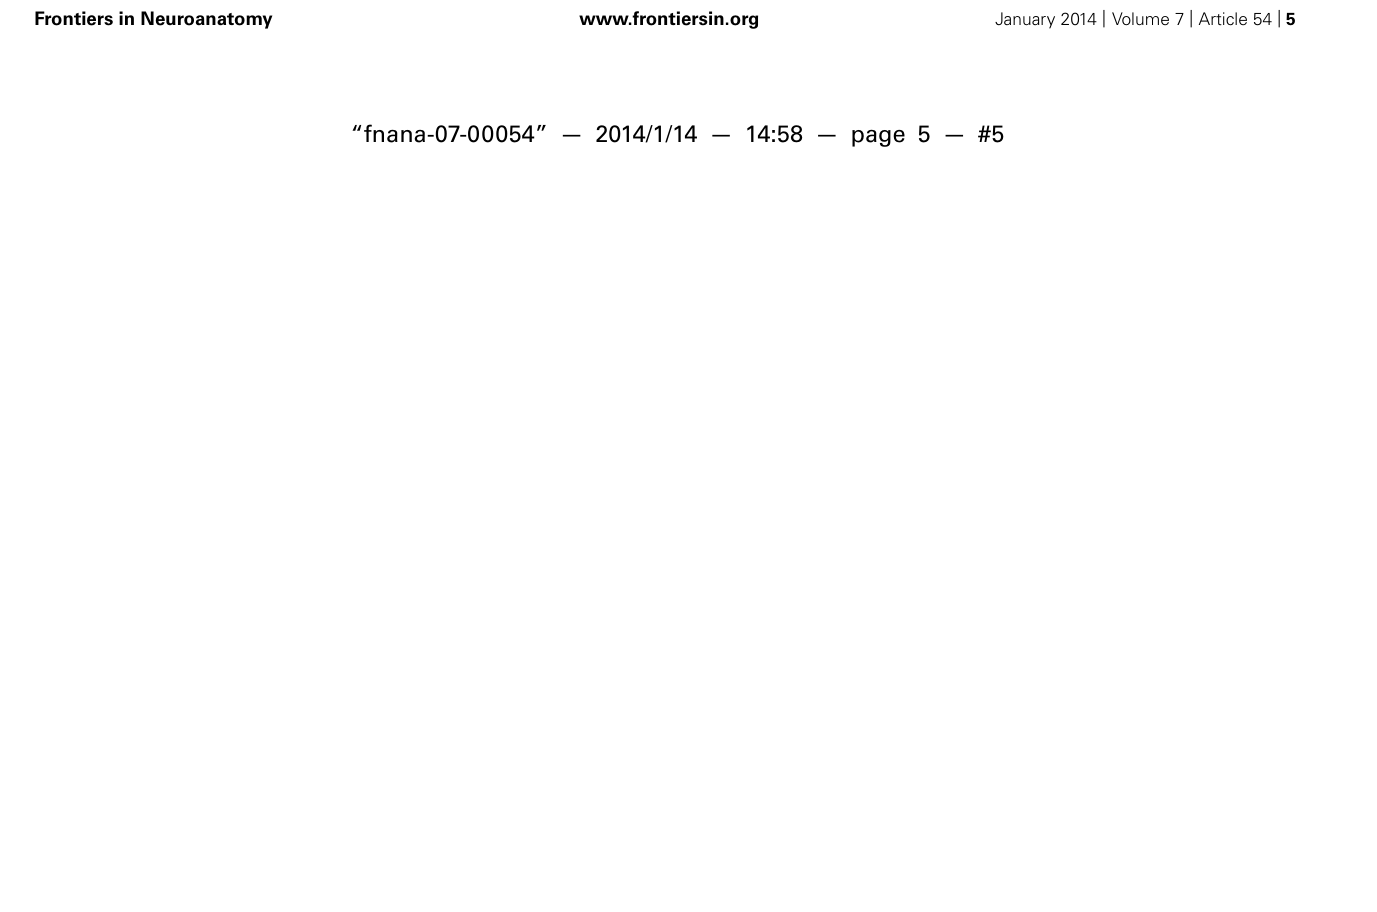
DLX2/PAX6 co-expression (J–L) photomicrograph of the alar hypothalamus stained against (J) PAX6 (green) and DLX2 (red) and (K,L) NKX2-2 (green). (J) The alar hypothalamus is characterized by PAX6. (K,L) NKX2-2 is expressed in the SVZ of the AB boundary and in post-mitotic cells giving rise to the PVN. Abbreviations see Figure 1 . Scale bars: 500 μ m in A–C,H,J,K ; 200 μ m in I ; 100 μ m in D ; 10 μ m in E–G,L